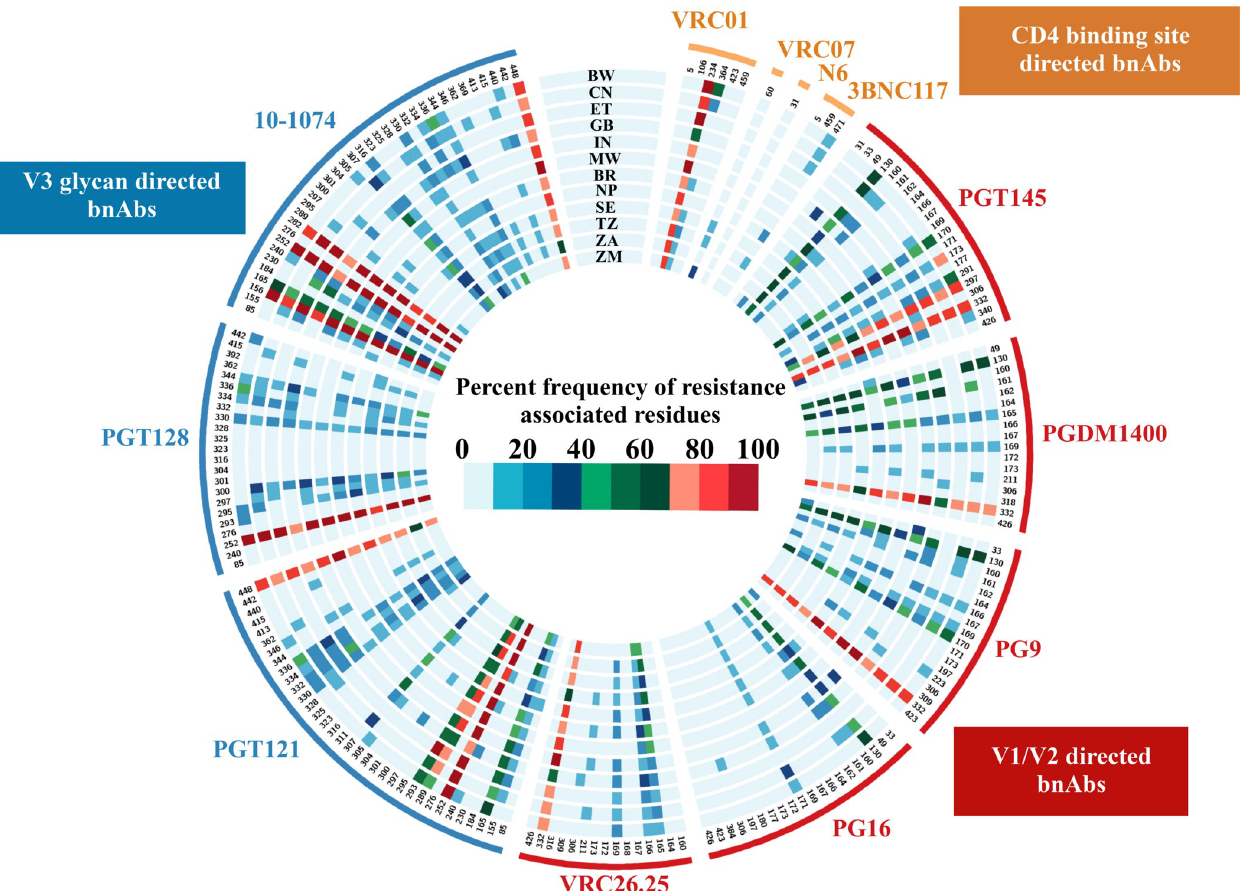
Fig 5. Abundance of bnAb resistance associated residues. A circos heatmap depicting abundance of bnAb resistance associated residues was plotted for 11 bnAbs (VRC01, VRC07, PGT121, PGT128, PGT145, PG9, PG16, VRC26.25, 3BNC117, 10–1074 and N6) wherein each track indicates the country of origin. Each pixel on the circular track indicates a specific residue position colored as per abundance of resistance causing residues at that position as per the color key.